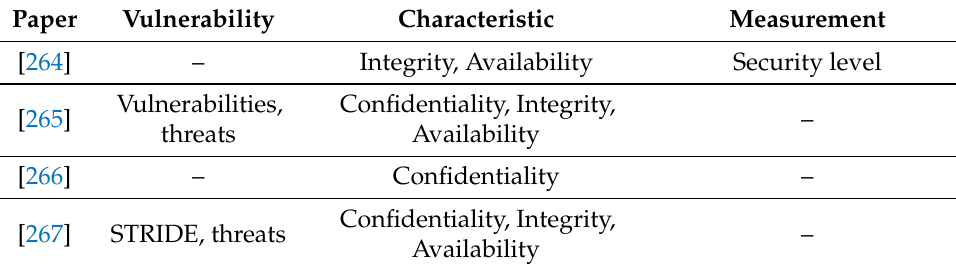
Table 6. Classification of latest papers: